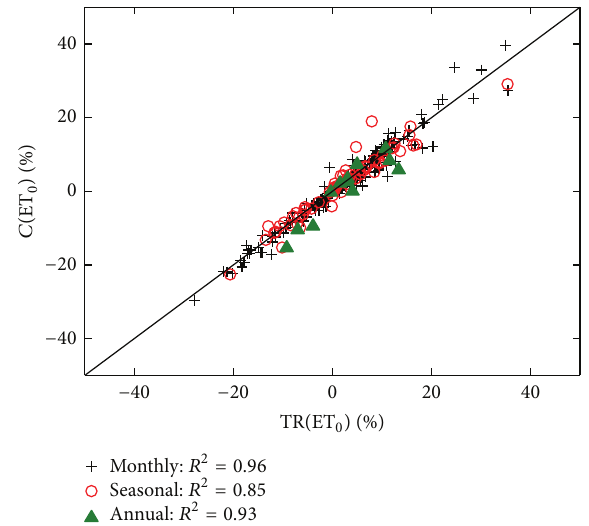
Figure 12: Relationship of 𝐶( ET 0 ) to TR ( ET 0 ) at different time scales for all stations in the HRB. 𝐶( ET 0 ) is the sum of the relative change of ET 0 contributed by changes in meteorological factors using (15). TR ( ET 0 ) is the long-term relative change of ET 0 from the observed